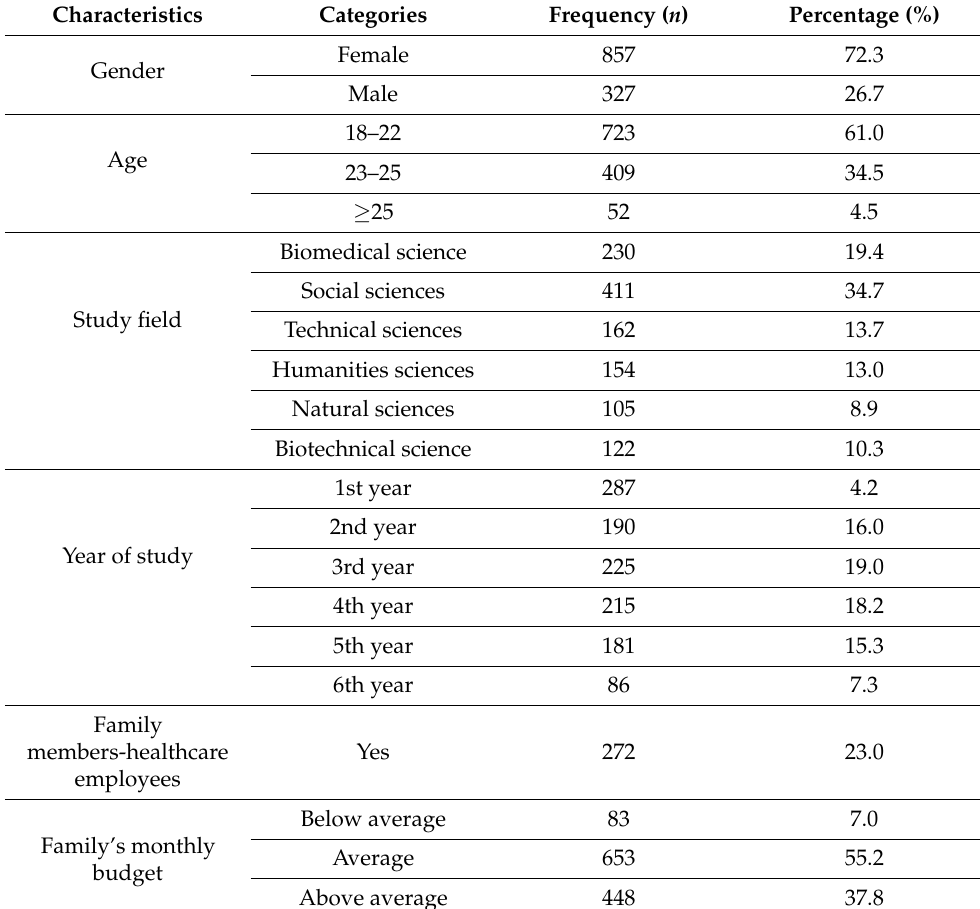
Table 1. Demographic characteristics of respondents according to the average score of knowledge about tobacco products and their adverse effects ( n =